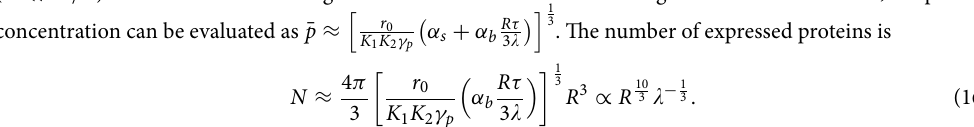
1 3 . The number of expressed proteins is